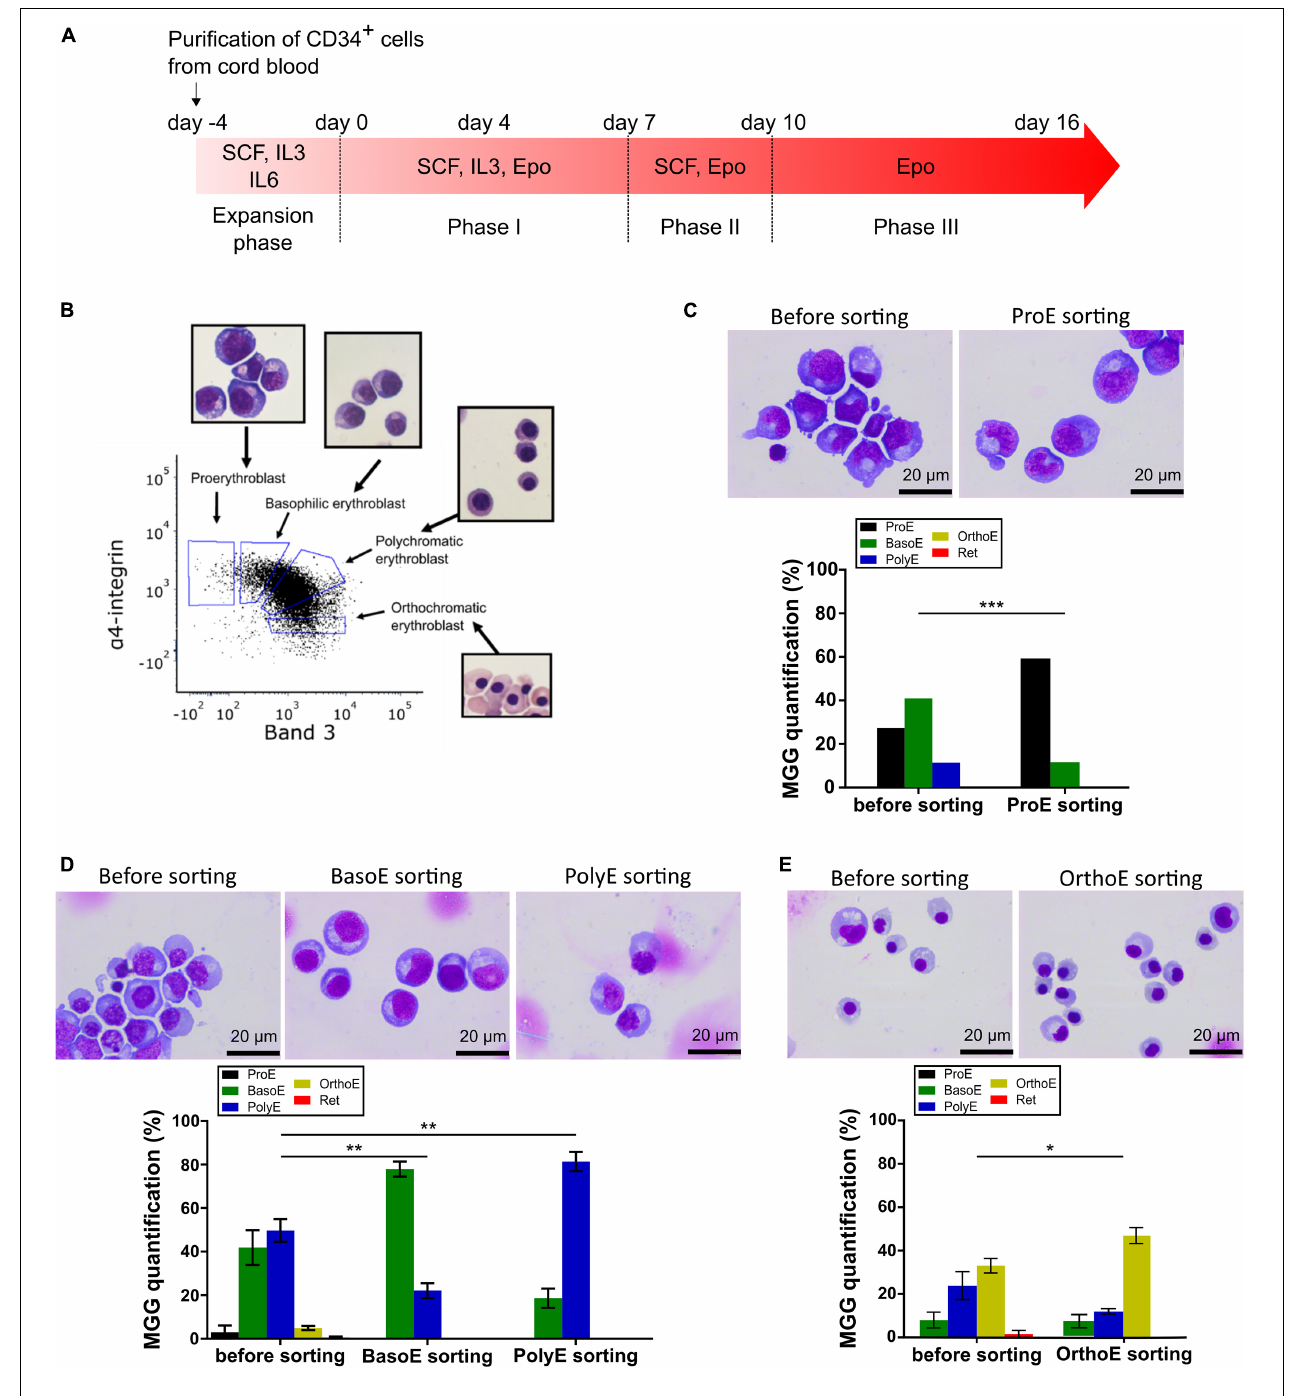
FIGURE 1 | Erythroblast enrichment prior analysis by electron microscopy. (A) Time course of CD34-positive cells ex vivo differentiation with the list of used cytokines at each stage. (B) Validation of sorting gates by MGG analysis of sorted cells on a representative flow cytometry panel of GPA-positive cells gated according to α -integrin and Band 3 protein expression at day 10 of differentiation. (C–E) MGG representative pictures (top) and quantification (bottom) of erythroid cells before and after sorting at day 6 (A) , day 12 (B) , and day 15 (C) . Mann–Whitney test was used. * p < 0.05; ** p < 0.01; *** p < 0.005.